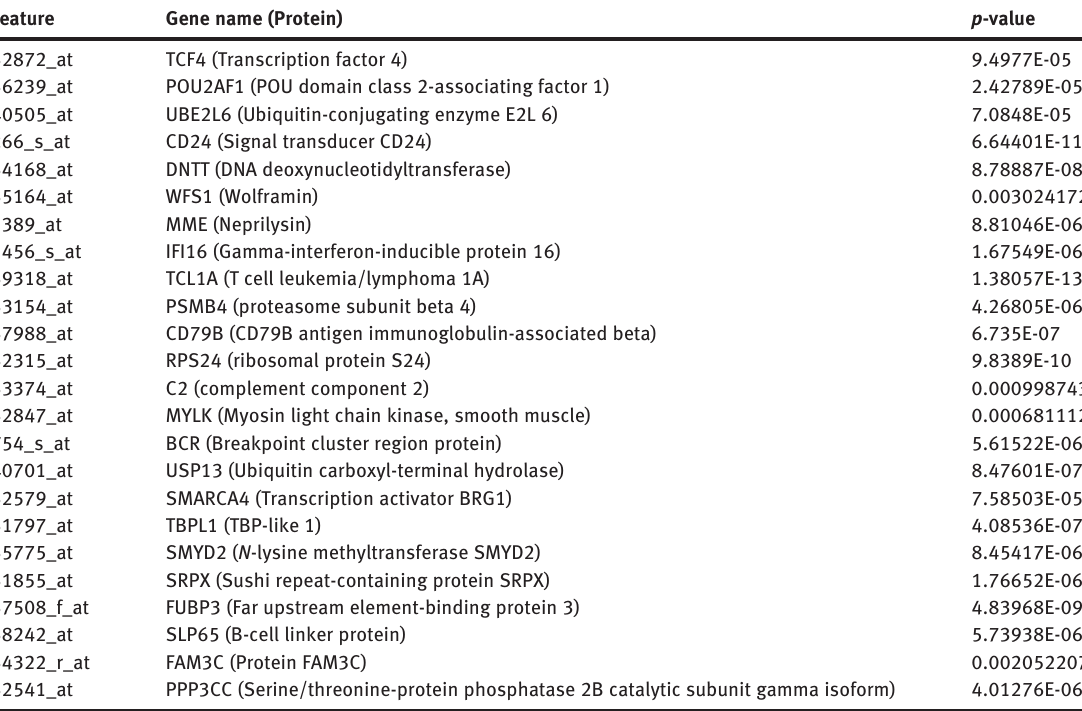
Table  : Features with highest average merit of information gain attribute selection after used metalearner chi-squared-KLR.